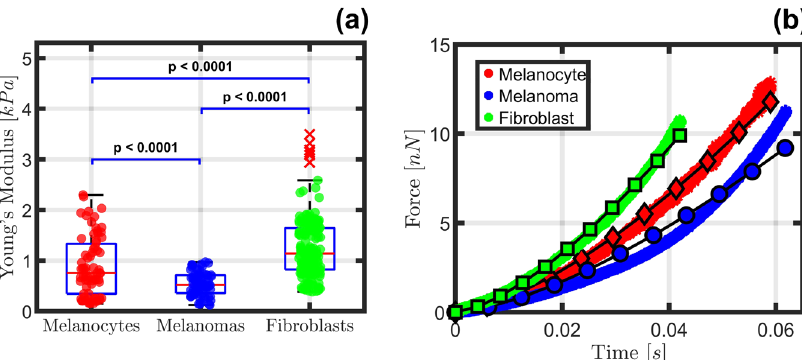
Fig. 5 Statistical analysis and corresponding force curve estimation by parameterizing Young ’ s modulus for each cell type. Pseudo-Elastic (Young ’ s) modulus distribution ( a ) and examples illustrating the fi t quality for the Pseudo-Elastic model ( b ) for the adherent human skin cell lines visualized in Fig. 3. This plot provides some insight regarding the overall stiffness for each cell type, speci fi cally that the melanoma cells appear softer than their healthy counterparts by a noticeable margin. The red markers indicate “ outlier ” values, which are determined to be more than 1.5 times the interquartile range away from the upper and lower bounds of the boxes. The Fibroblasts showcase the only outliers by this de fi nition, which can be reasonably expected because signi fi cantly more curves were acquired for that cell line. The number of cells analyzed per cell type is n = 12 melanocytes, n = 13 melanoma cells, and n = 33 fi broblasts. Data are represented as mean ± deviation with signi fi cant difference between cell types determined by unpaired two-tailed Student ’ s t-test with Welch ’ s correction indicated as, * P < 0.05. Note that the sparse markers for the model estimations included in ( b ) are deliberately periodically spaced for representation purposes to differentiate the model estimation from the dataset — there are an equivalent number of model and AFM observable datapoints. The standard error for each cell type is provided in Supplementary Table 2.